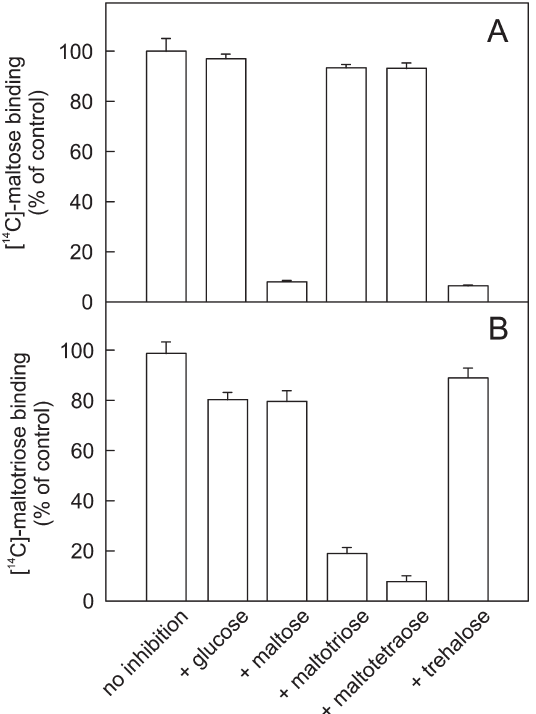
Figure 6. Substrate specificity of the ConA fraction derived from cells grown on maltose. The binding of (A) 1 mM [ 14 C]-maltose or (B) 1 mM [ 14 C]-maltotriose to the ConA fraction was inhibited by addi- tion of a 10-fold excess of unlabeled substrate.